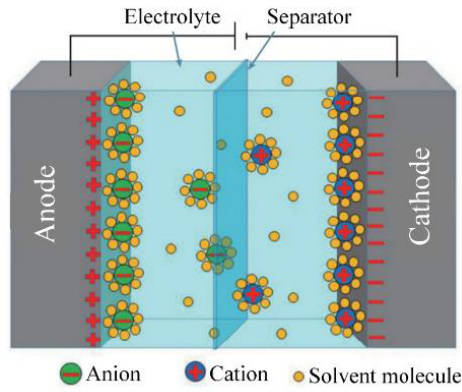
Figure 17. Schematic representation of an electric double layer capacitor (EDLC), where two electrodes are submerged in an aqueous electrolytic solution and are separated by an ion permeable separator [59].